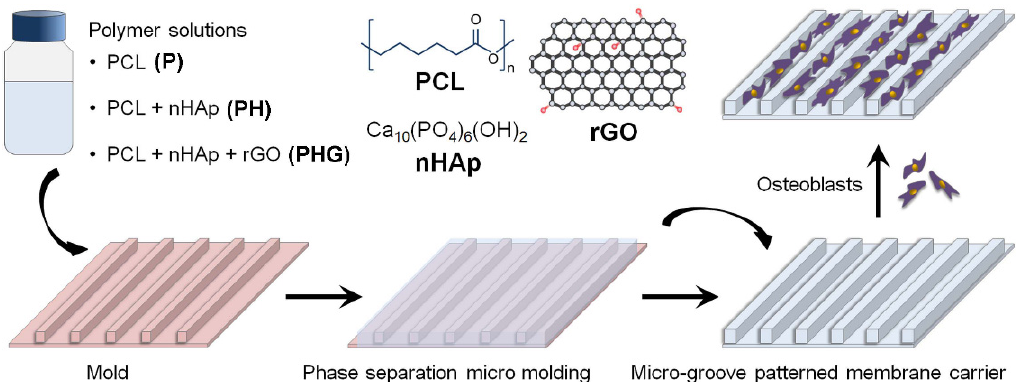
Figure 1. Schematic illustration of micro-patterned polymer/polymer composite membrane formation on silicone mold by the phase separation micromolding (PS µ M) method and its use as a human osteoblastic cell carrier substrate.